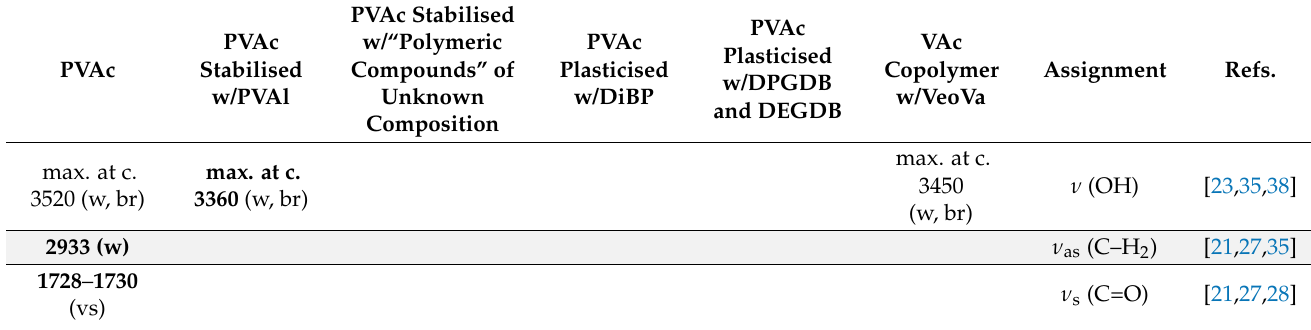
Table 3. Suggested spectral markers in ATR-FTIR and assignment for several components of the studied vinyl acetate- based